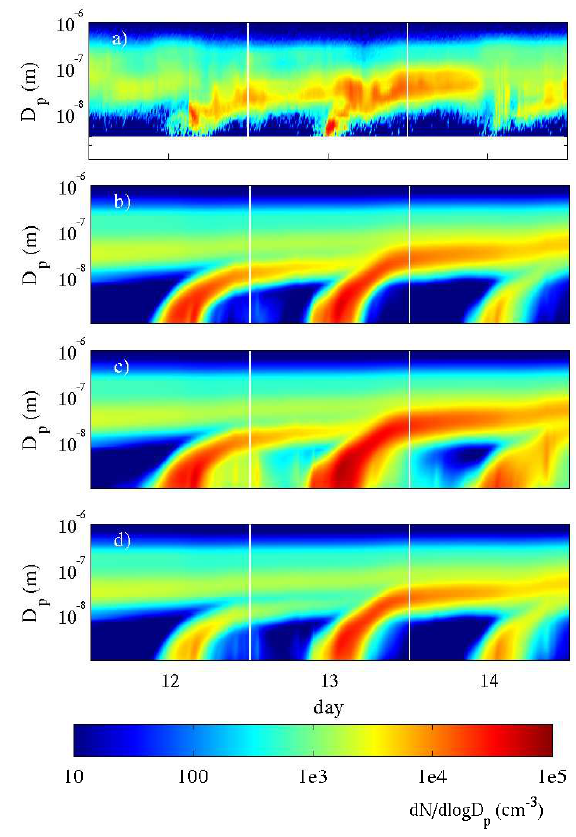
Fig. 2. (a) Observed particle formation events. (b) Typical event simulation for kinetic nucleation (Eq. 1). (c) Typical event when the nucleation rate depends on reaction products of monoterpenes with O 3 (Eq. 2) and (d) typical event when the nucleation rate depends on reaction products of monoterpenes with OH (Eq.